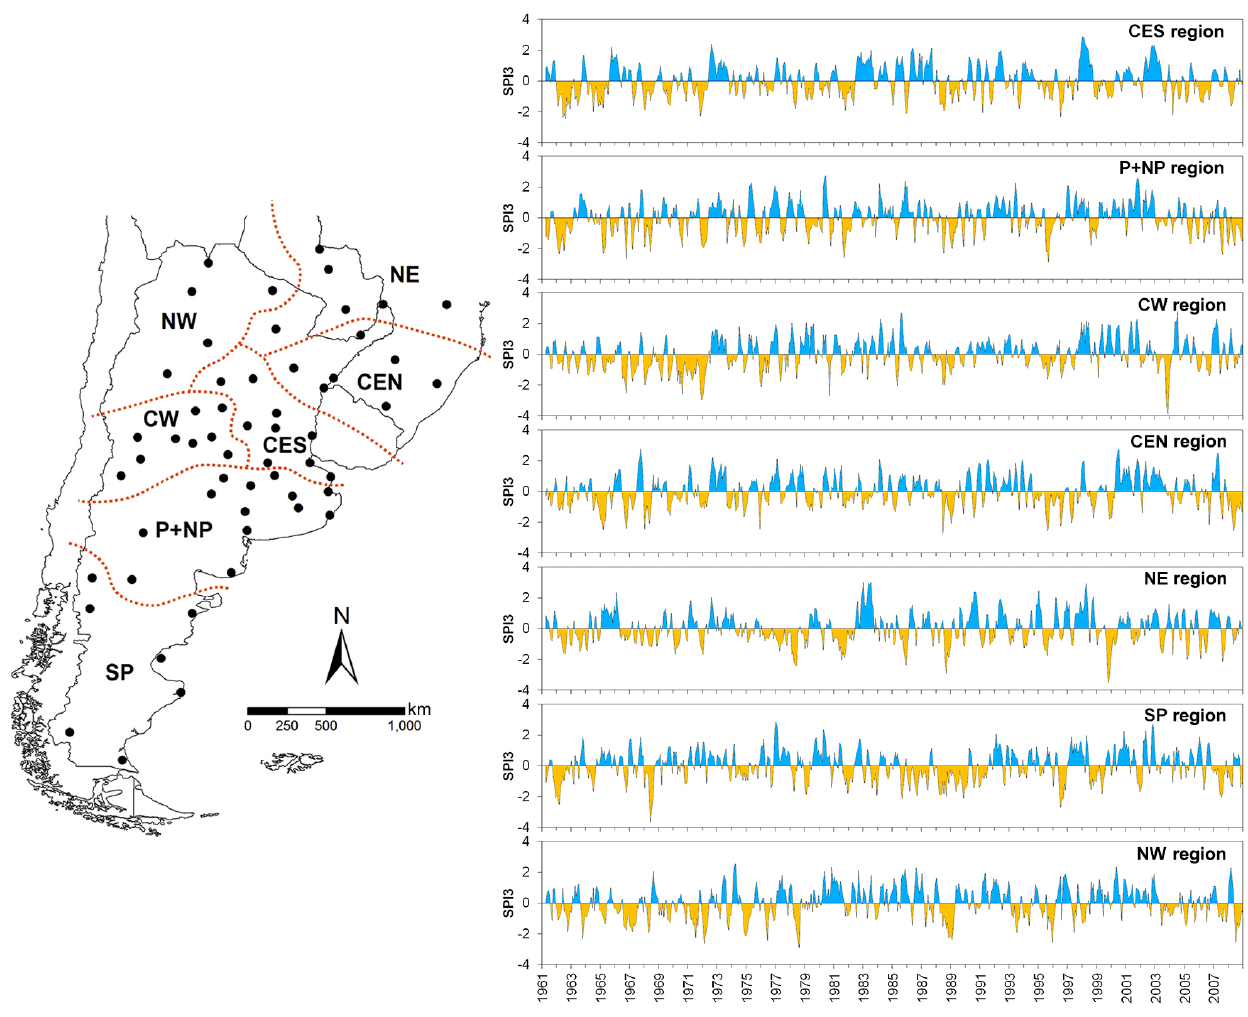
Figure 3. Regions obtained through RPCA applied to the SPI3 time series (left) and its corresponding regional temporal patterns